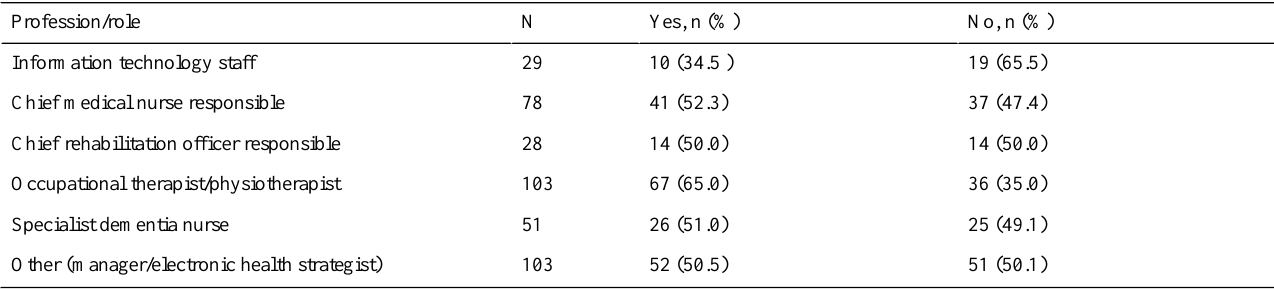
Table 2. Distribution of responses regarding experimentation with and purchase of new welfare technology in relation to profession/role (N=393).